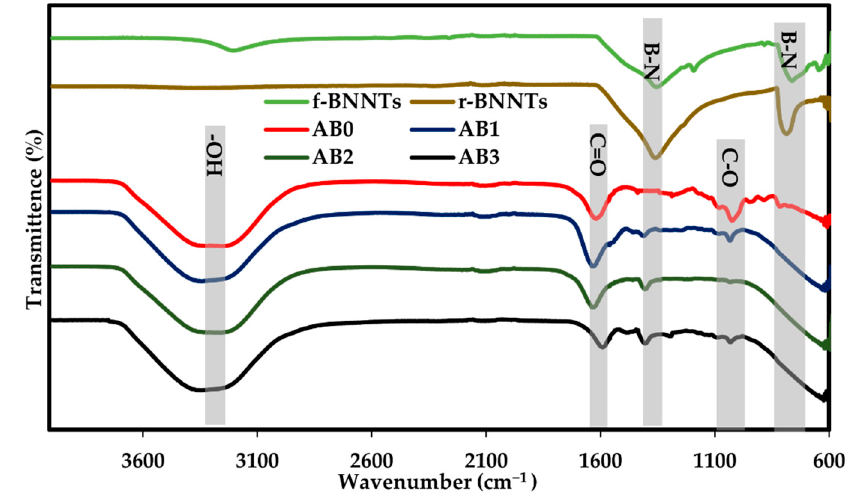
Figure 6. FITR spectra of BNNTs and AB ink solutions. Figure 6. FTIR spectra of BNNTs and AB ink